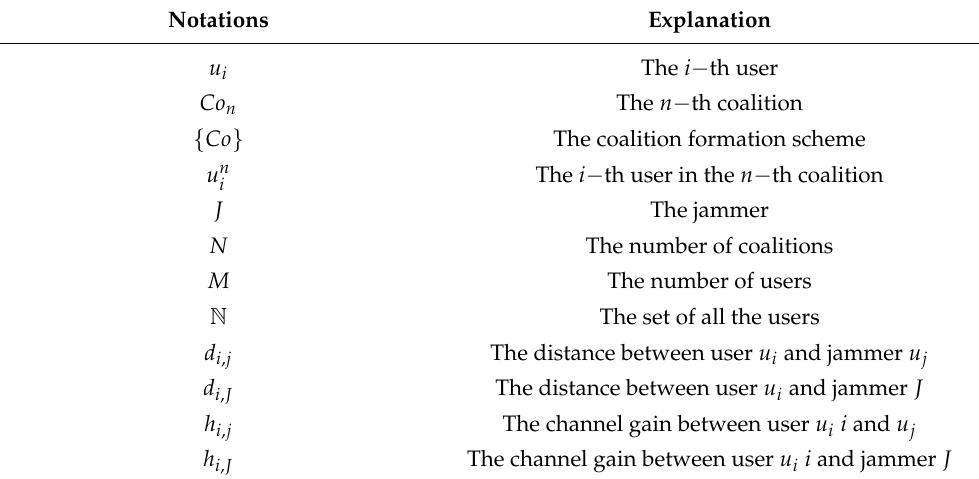
Table 1. Summation of